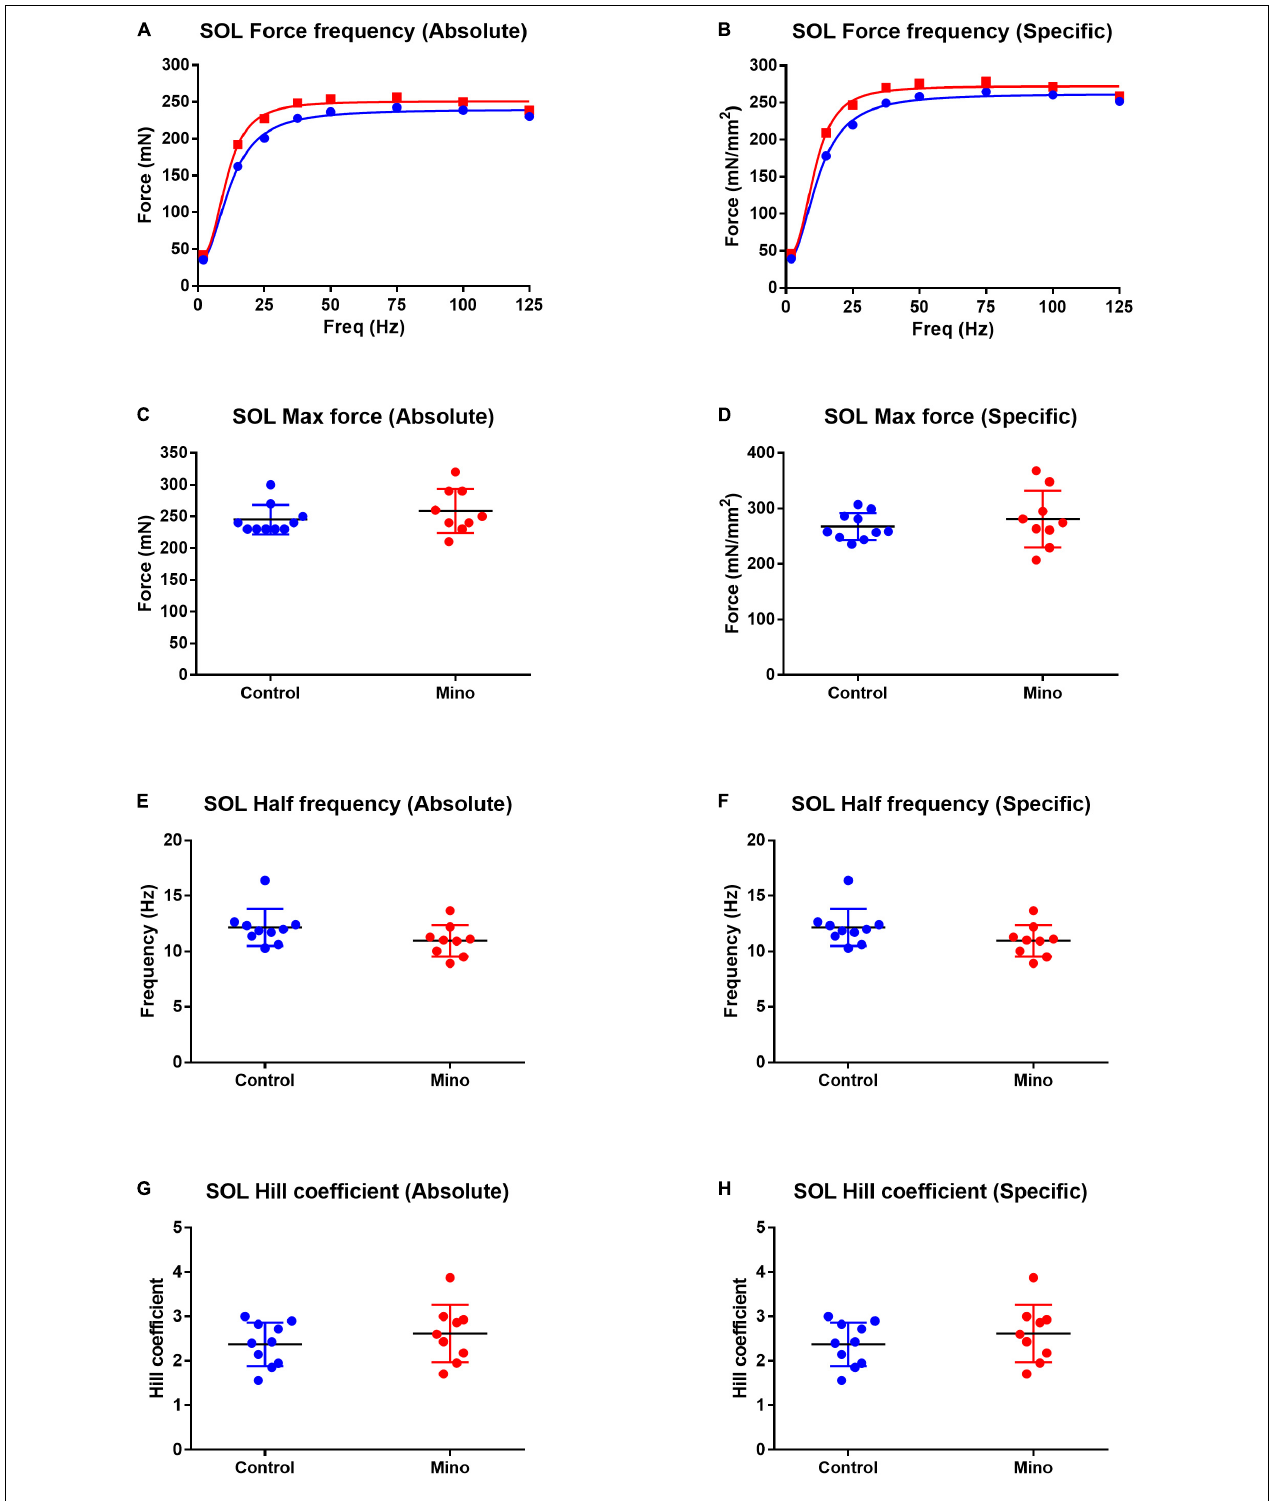
FIGURE 2 | Force frequency characteristics of the slow-twitch soleus muscle expressed in absolute and specific (relative to muscle CSA) units from control (blue) and minocycline (Mino; red) groups. (A,B) Force frequency curve from the soleus in absolute (A) and specific (B) units, which were not different with minocycline treatment. (C,D) soleus maximal force was not different with minocycline treatment either in absolute (C) or specific (D) units. (E,F) Soleus half frequency was not different with minocycline treatment in either absolute (E) or specific (F) units. (G,H) Soleus Hill coefficient was not different with minocycline treatment in either absolute (G) or specific (H) units. For all measurements, n = 10 for Control, and n = 9 for Mino. Values are mean ± SD.